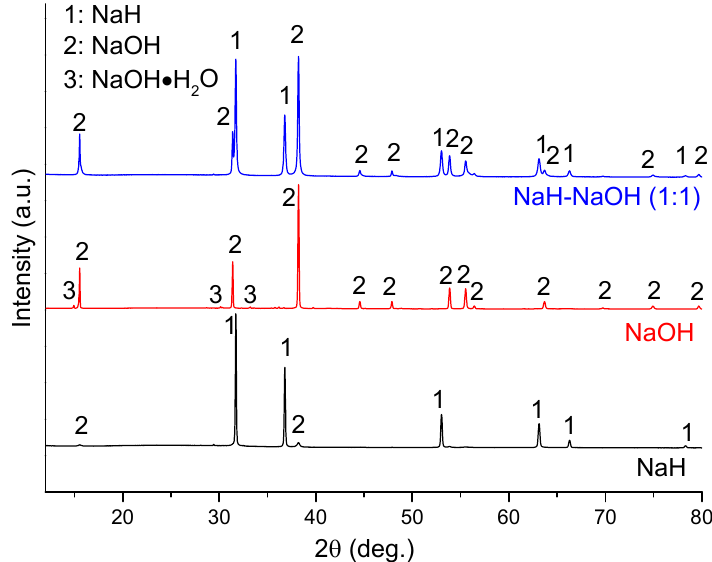
Figure 3. PXD patterns of as-received NaH and NaOH, and as-milled NaH-NaOH (1:1), sample